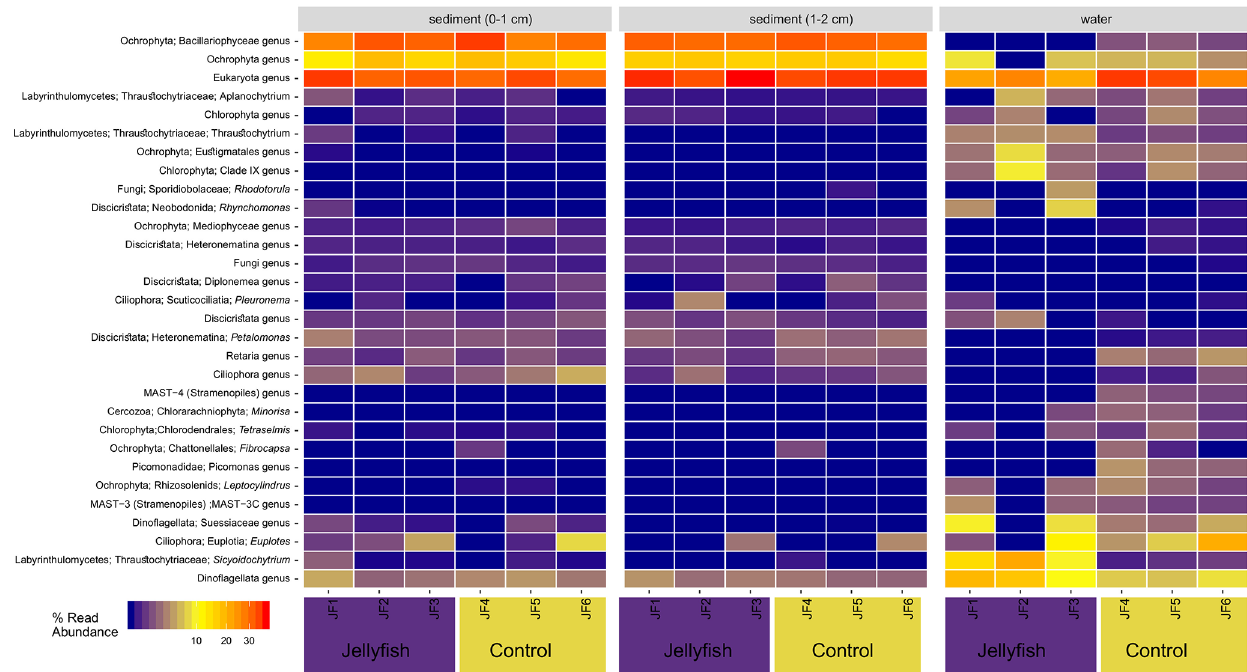
Figure C2. Eukaryote diversity of seawater and sediment samples collected from jellyfish-enriched and control experimental cylinders. The 30 most abundant lineages are presented and organized by hierarchical clustering. Color scale denotes the relative abundance of reads (%).